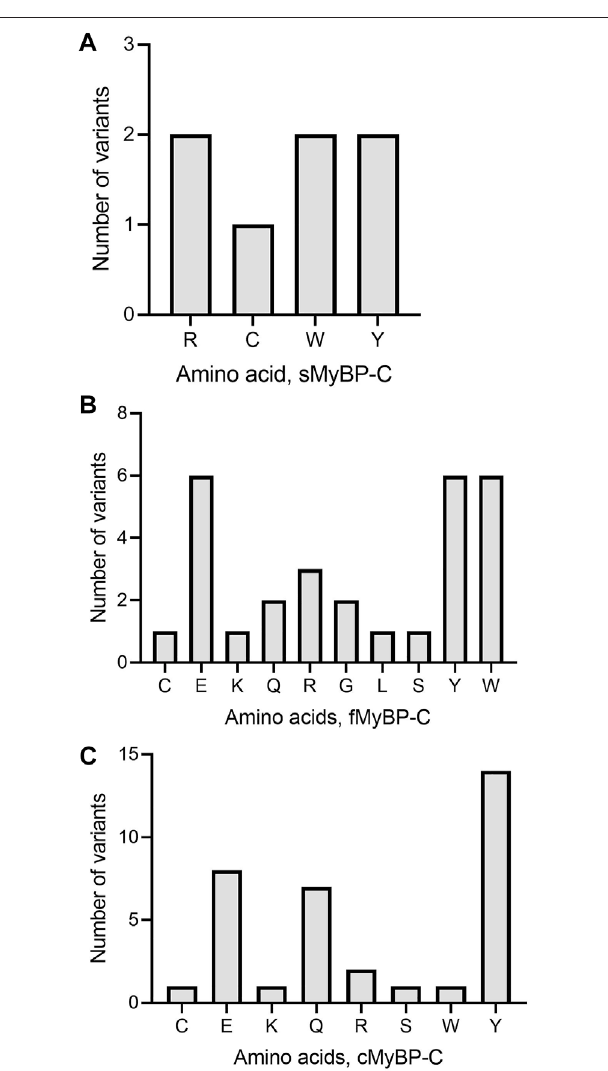
FIGURE 7 | Prevalence of amino acids targeted to introduce premature terminationintheMyBP-Cgenefamily.Trp(W)andArg(R)werethetopamino acids introducing a prematurely terminated stop codon in sMyBP-C protein (A) , and Glu (E) was the most targeted amino acid in both fMyBP-C (B) and cMyBP-C (C) protein. Lastly, Tyr (Y) was the most prevalent amino acid leading to premature termination and causing C ′ -terminal truncation in all three